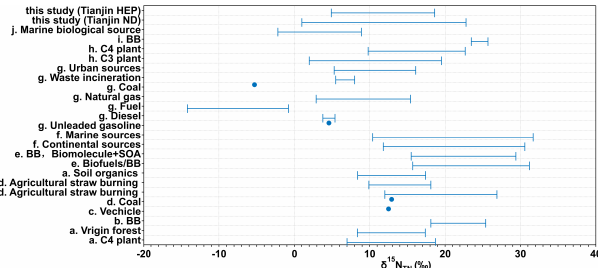
Figure 13. Range or mean δ 15 N TN in the particles emitted from point sources, source substances, and atmospheric aerosols from different sites around the world. (a) Martinelli et al. (2002); (b) Ag- garwal et al. (2013); (c) Kunwar et al. (2016); (d) Kundu et al. (2010); (e) Pavuluri et al. (2010); (f) Bikkina et al. (2016); (g) Widory (2007); (h) Turekian et al. (1998); (i) Kundu et al. (2010); (j) Miyazaki et al. (2011).